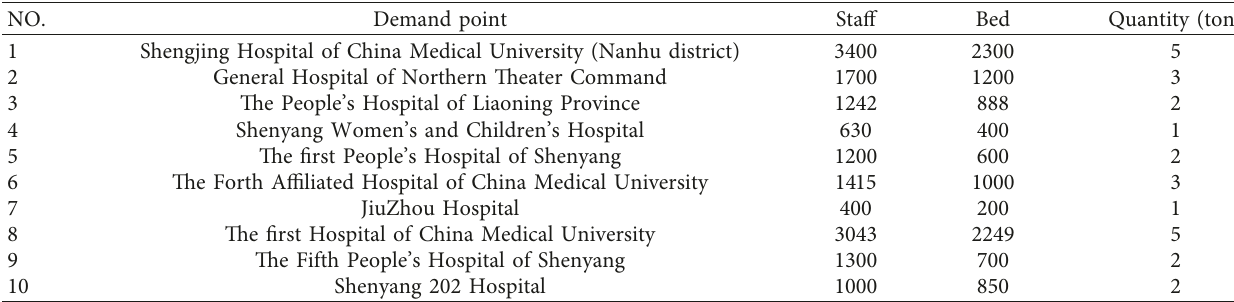
Table 3: Basic parameters of each demand